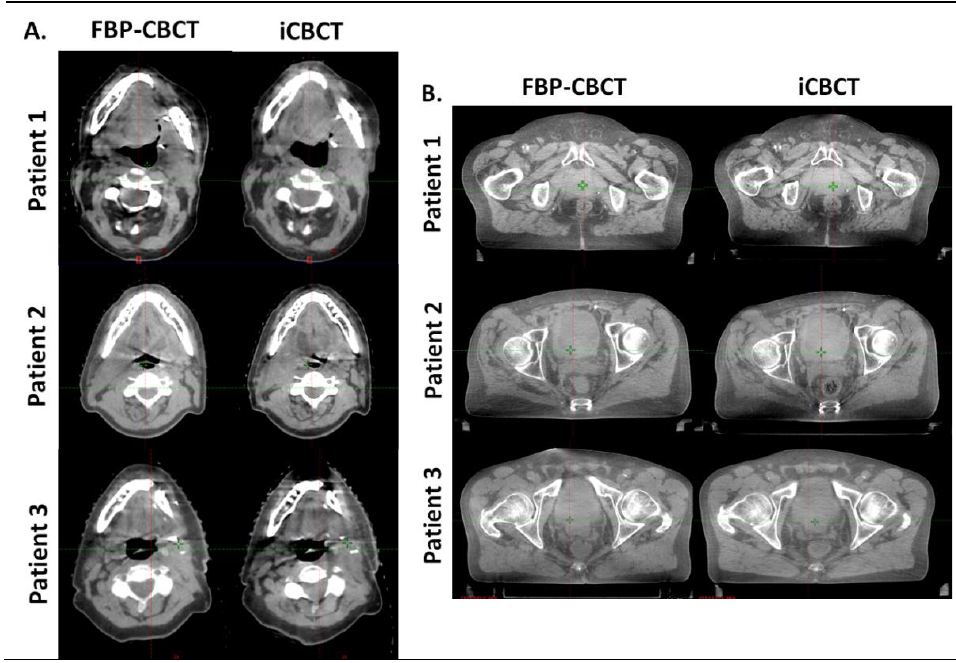
Figure 4. Comparison of head and neck ( A ) and pelvis ( B ) reconstruction with FBP (FBP-CBCT) and IR (iCBCT) on three patients . The series were matched on the same location and visualized with the same windowing.